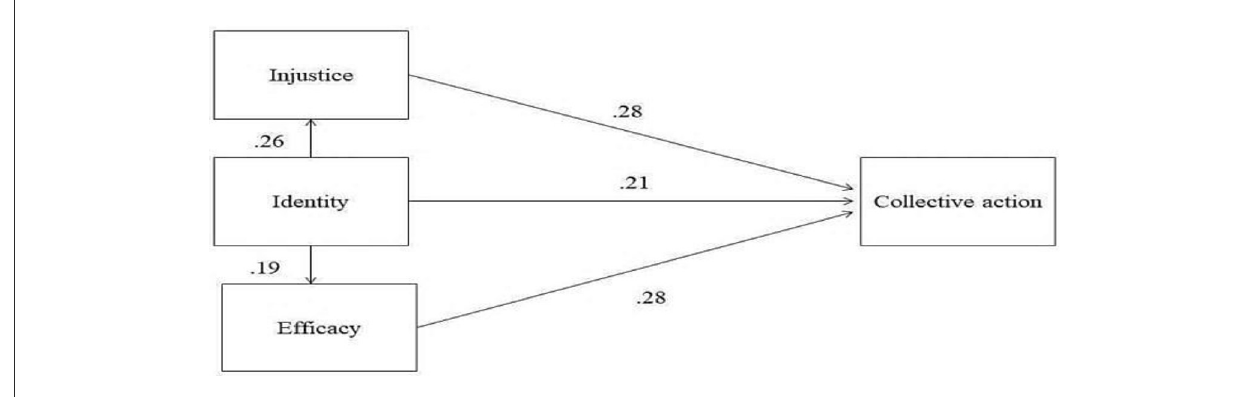
FIGURE5 SIMCA model. Source: van Zomeren et al. (2008).